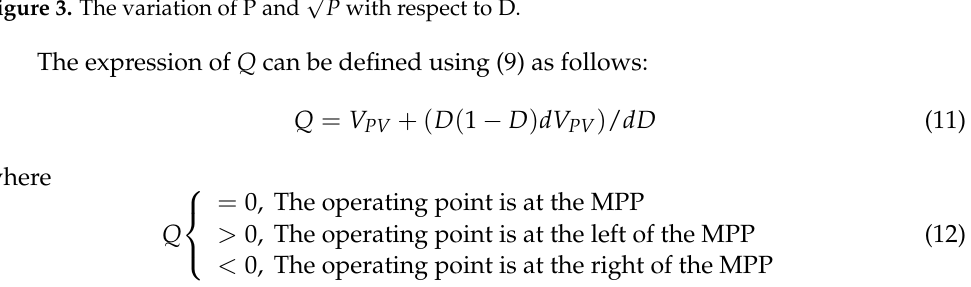
√ P with respect to